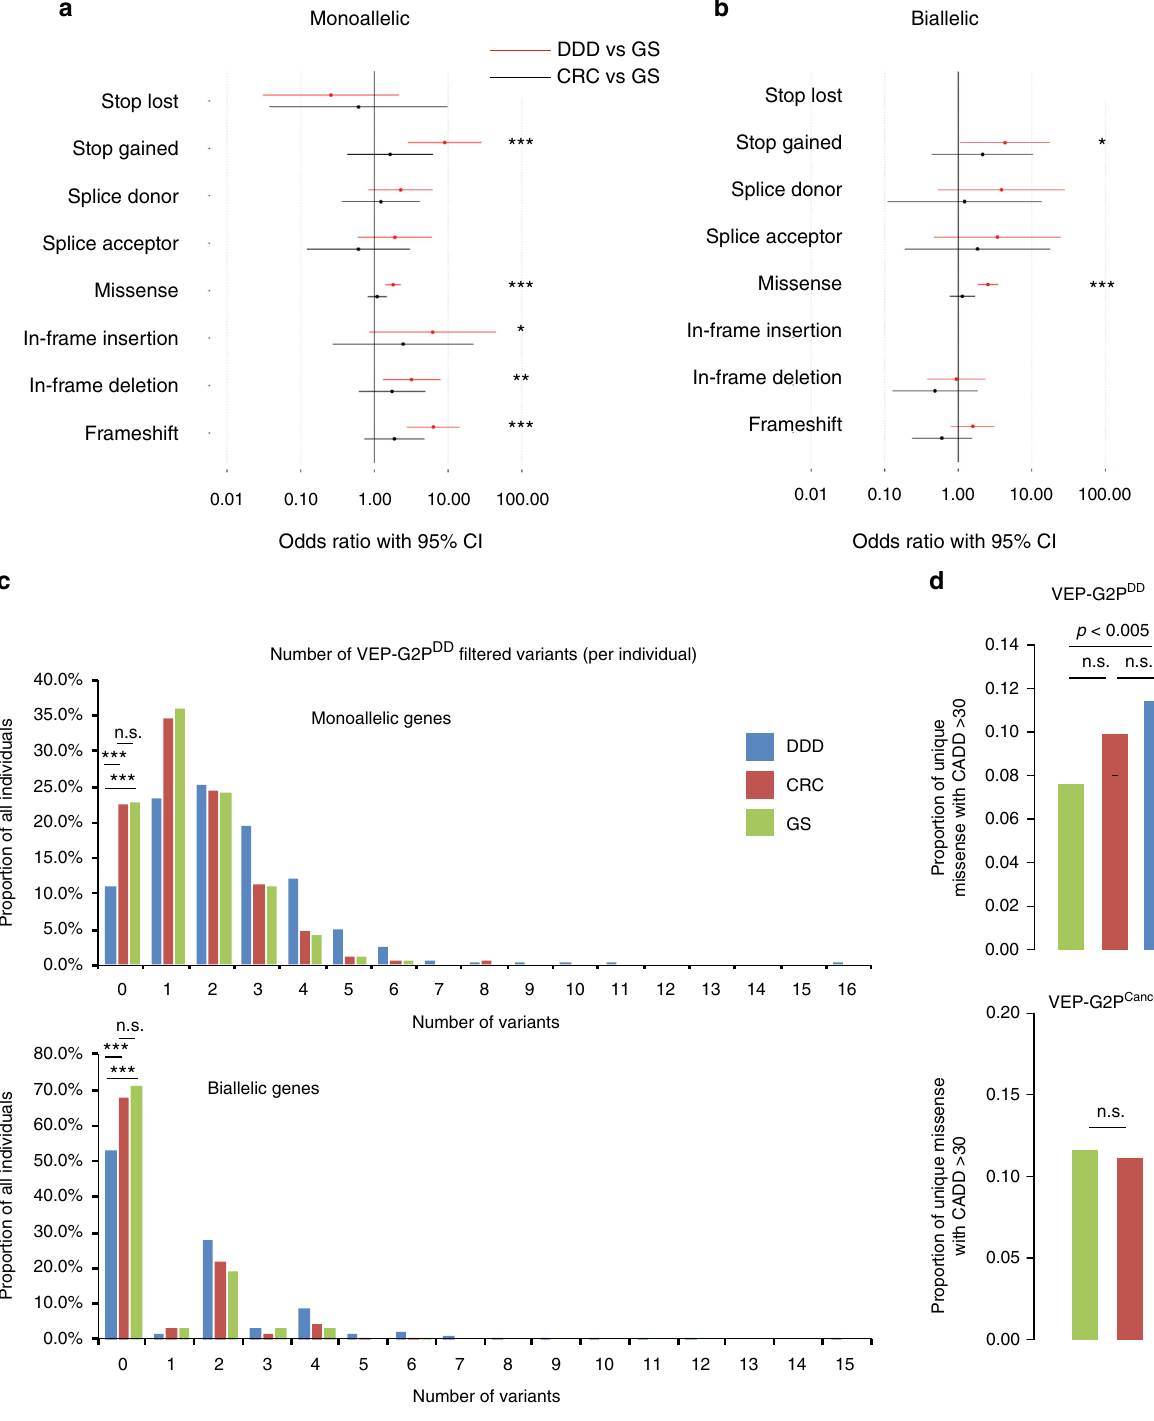
probands 13 . Our primary aim was to evaluate LGMDETs — the